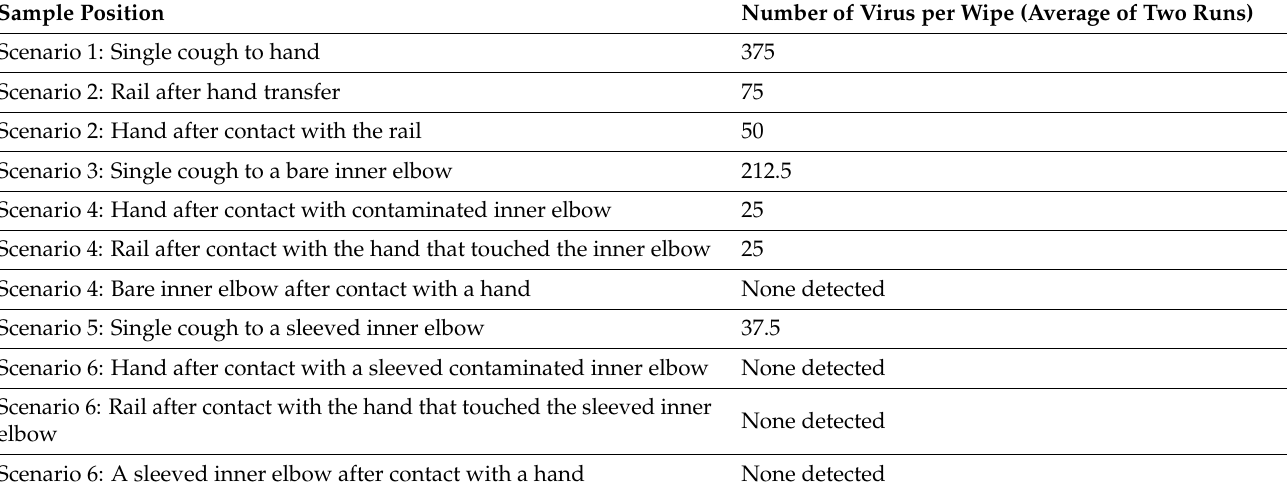
Table 3. Viral transfer per